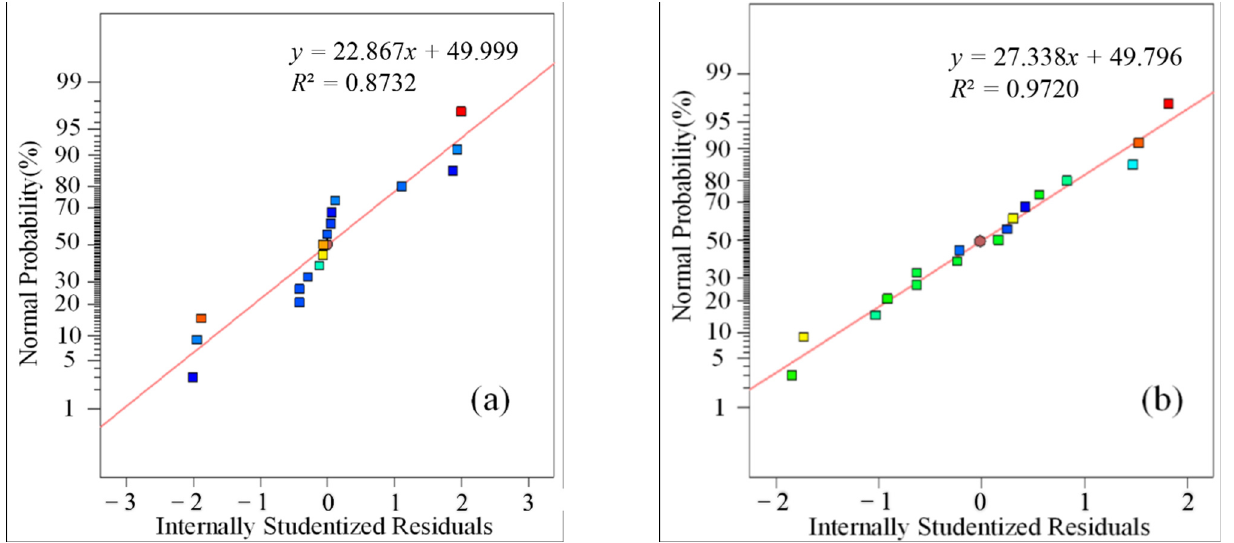
Figure 8. The residual analysis of specific power consumption and throwing speed: ( a ) Specific power consumption; ( b ) Throwing speed.